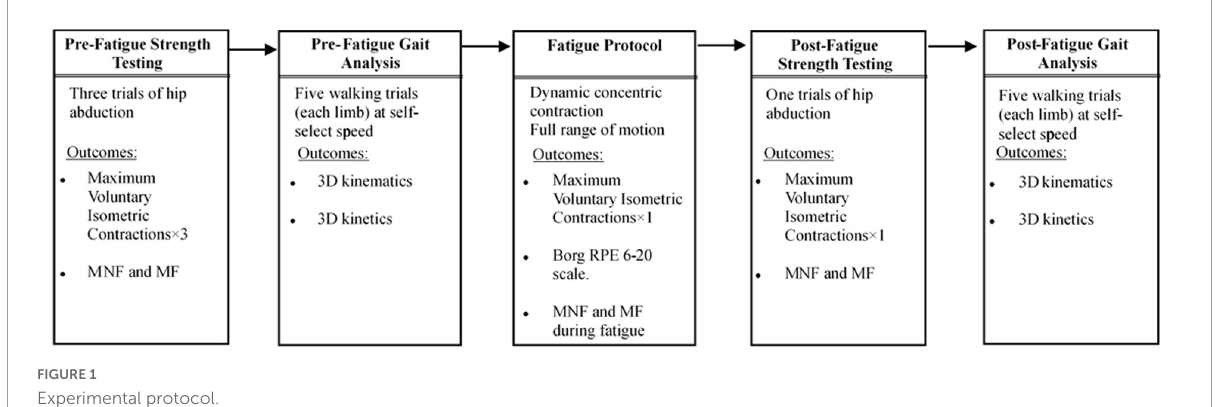
FIGURE1 Experimental protocol.